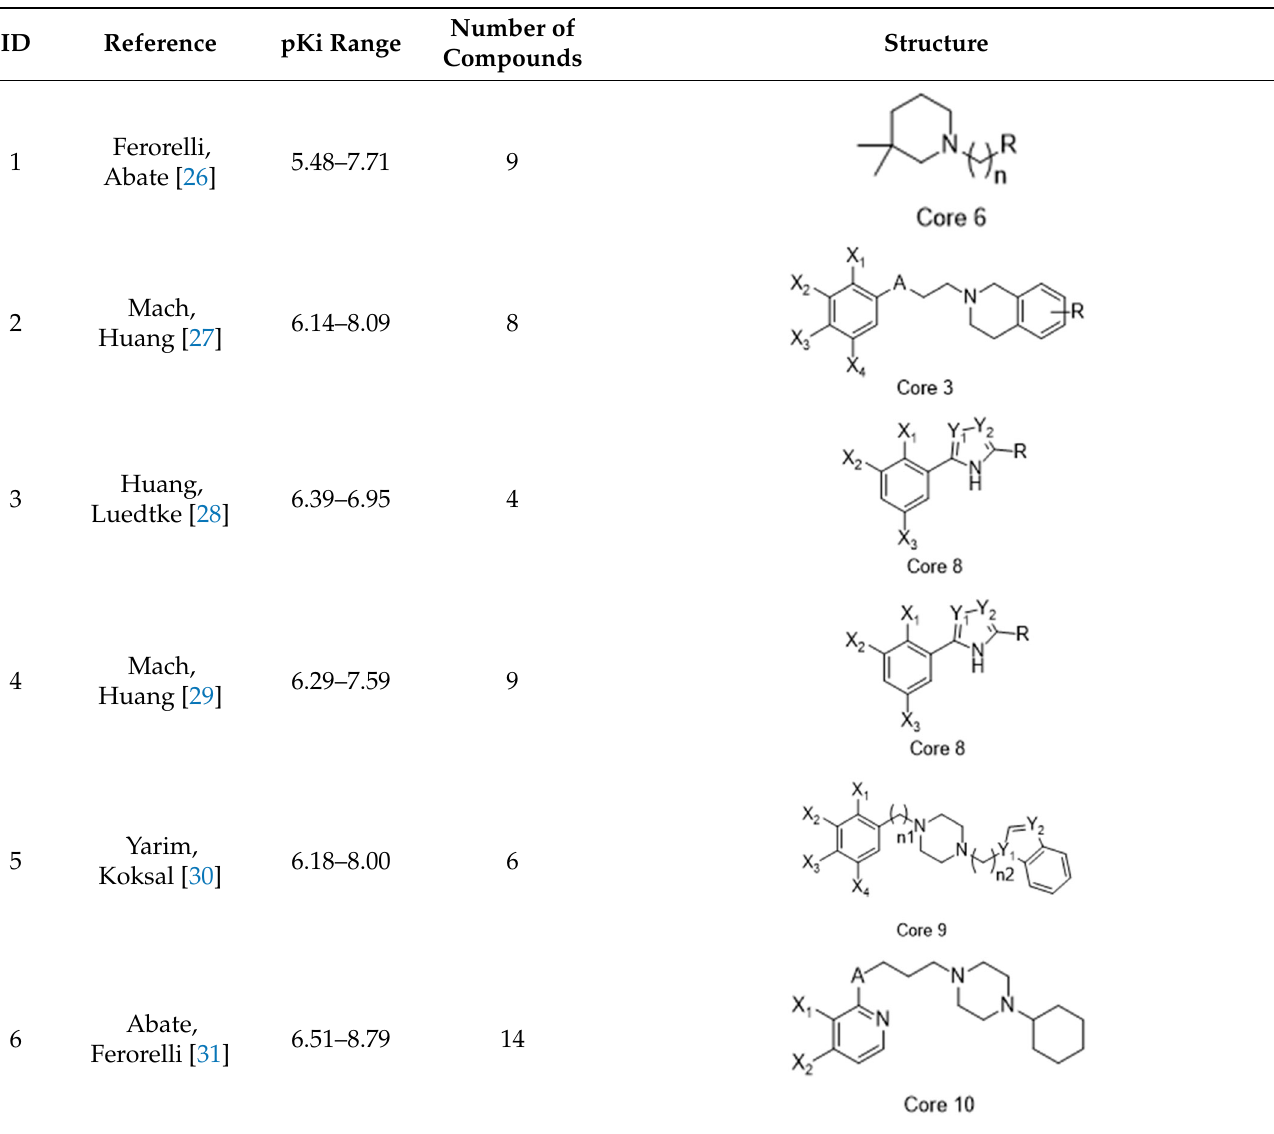
Table 1. Summary of the 159 S2R-active compounds, including their generic structure, number of compounds, and published source, compiled for the QSAR